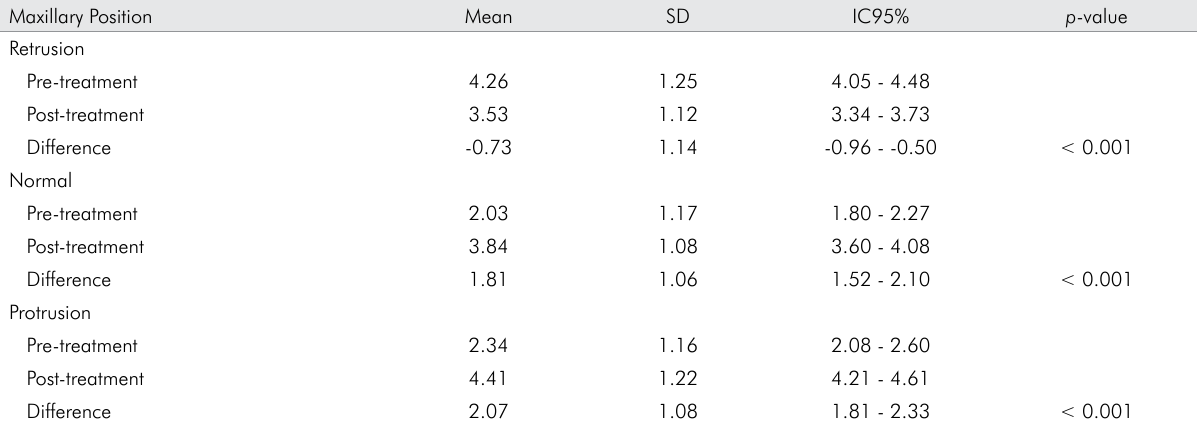
Table 3. Differences in the evaluations between the pre-treatment and post-treatment silhouettes.